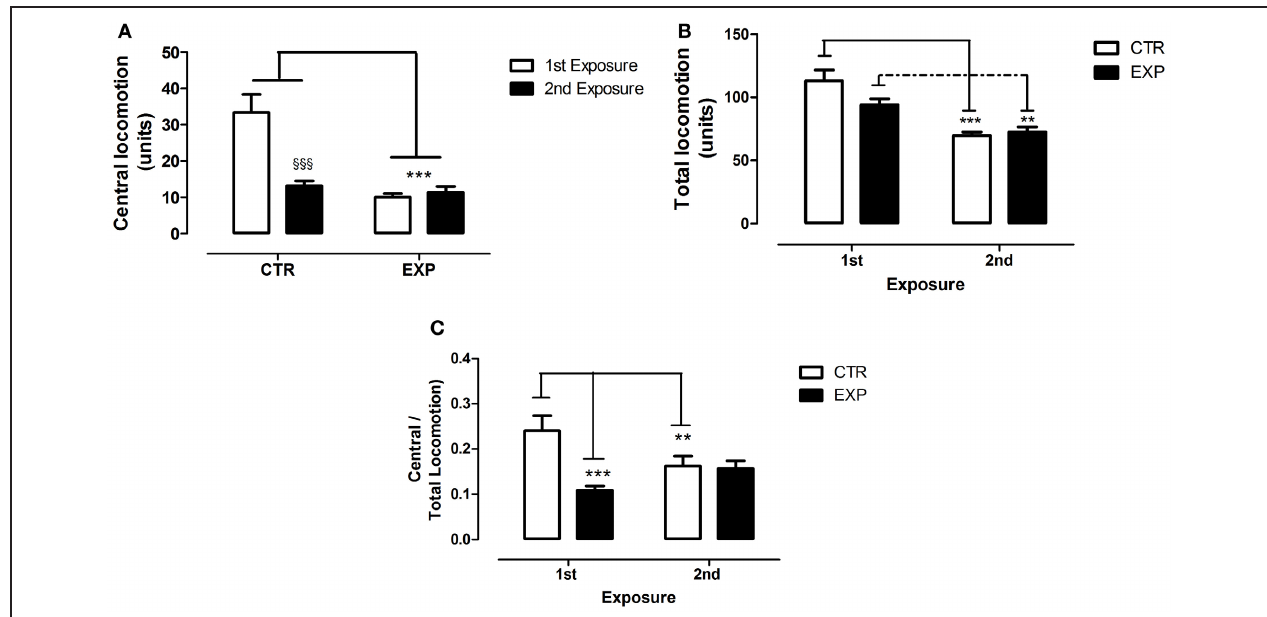
FIGURE 7 | Central (A), total locomotion (B) and (C) ratio of central to total locomotion are shown as mean ± standard error in both exposures. Control group (CTR) n = 14 and Experimental group (EXP), n = 16. Reduced central locomotion was noted for EXP in both exposures. In CTR, the locomotor activity in central squares decreased significantly